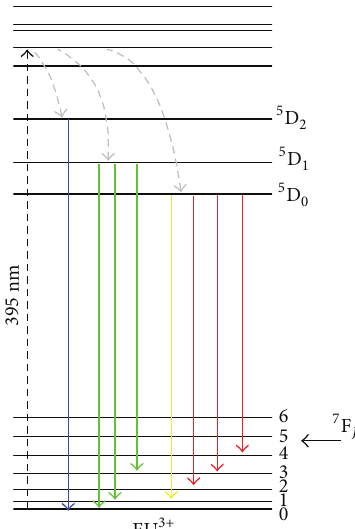
Figure 4: Scheme of energy levels of Eu 3+ in Yb 2 O 3 and possible mechanical energy level diagram for Eu 3+ after pumping excitation at 395 nm.